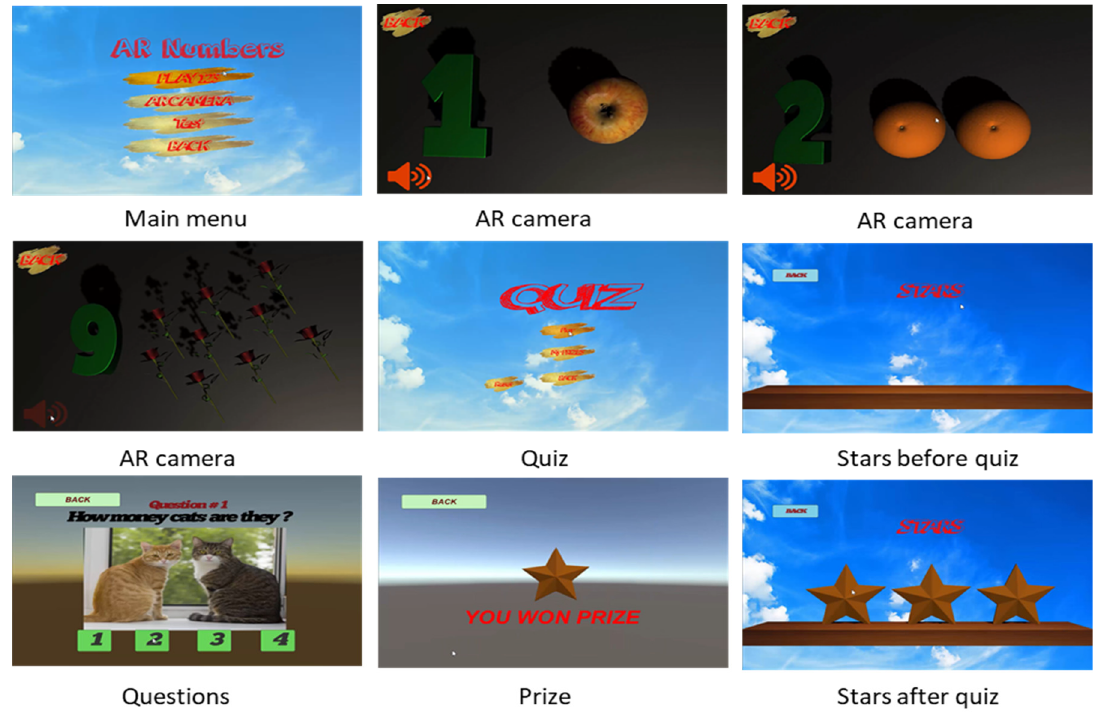
Figure 6. Screenshot visuals of the application “AR Numbers” where students learn decimal numbers.